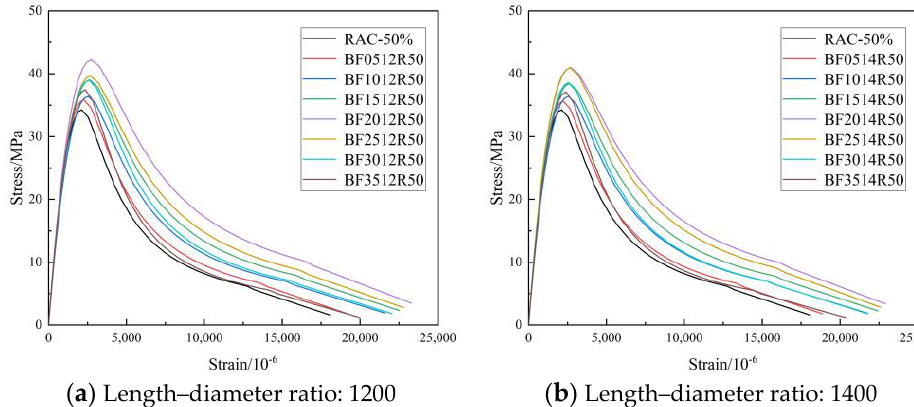
Figure 13. Complete stress – strain curve of BFRAC-50% under uniaxial compression.